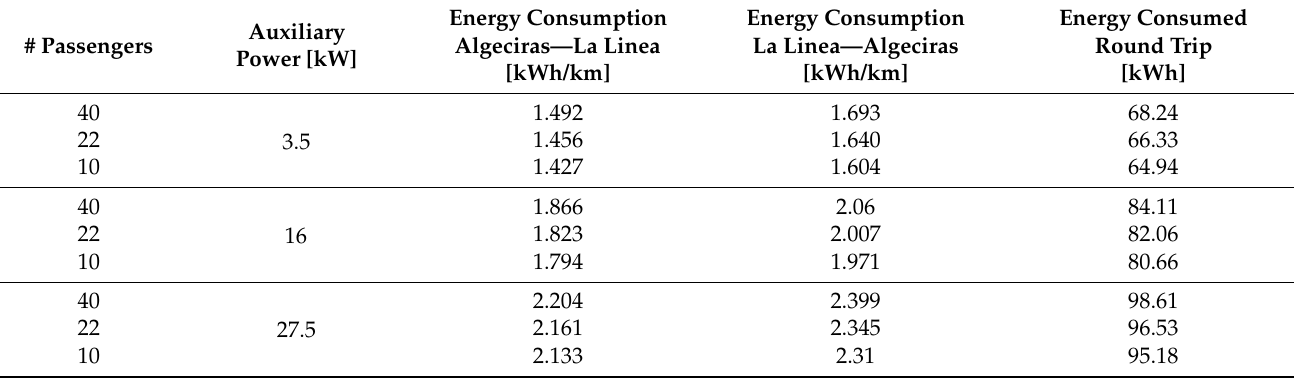
Table 3. Line M-120D simulation results for electric bus.